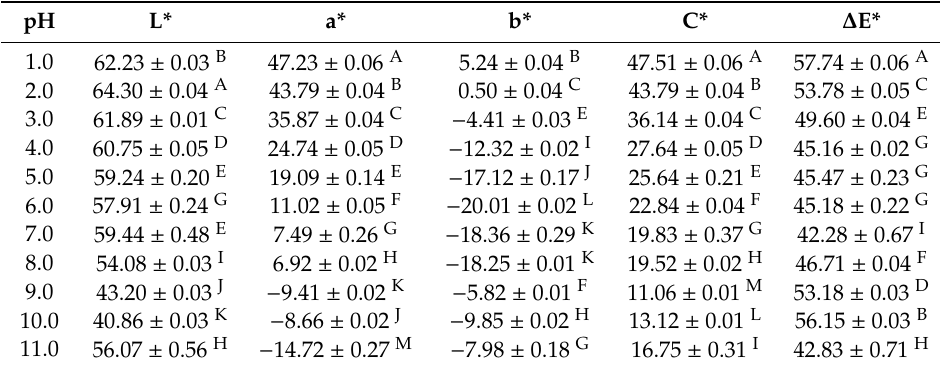
Average values (n = 5) with the same superscript within a column are not significantly di ff erent at 5% level (p > 0.05). Number of data demonstrated Significant di ff erence: L* = 9; a* = 13; b* = 11; C* = 13; ∆ E* = 8. Total significant = 54. Significant data percentage = 83.08%.